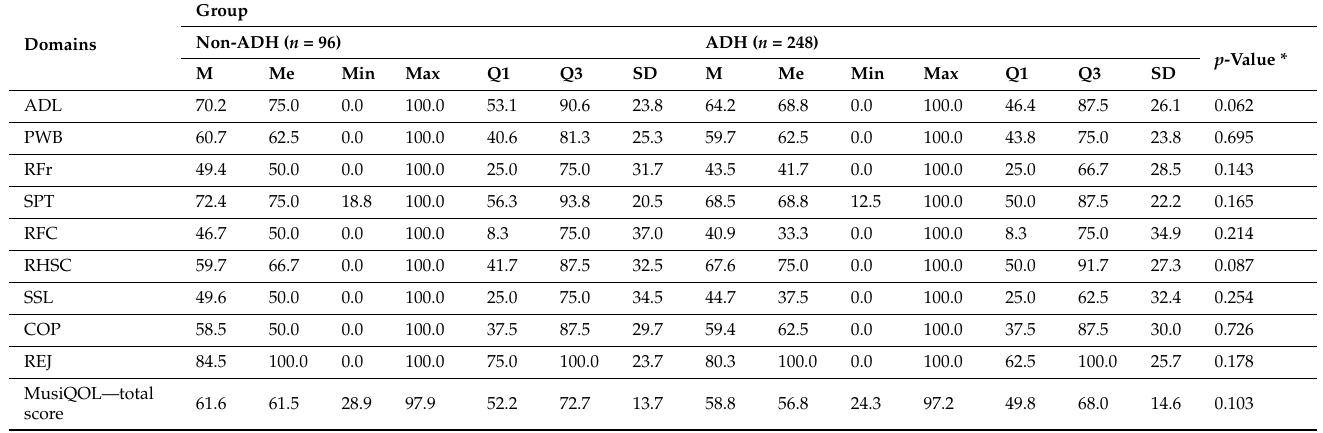
Table 4. Comparison of the results of the MusiQOL questionnaire between adherent and non-adherent patients.